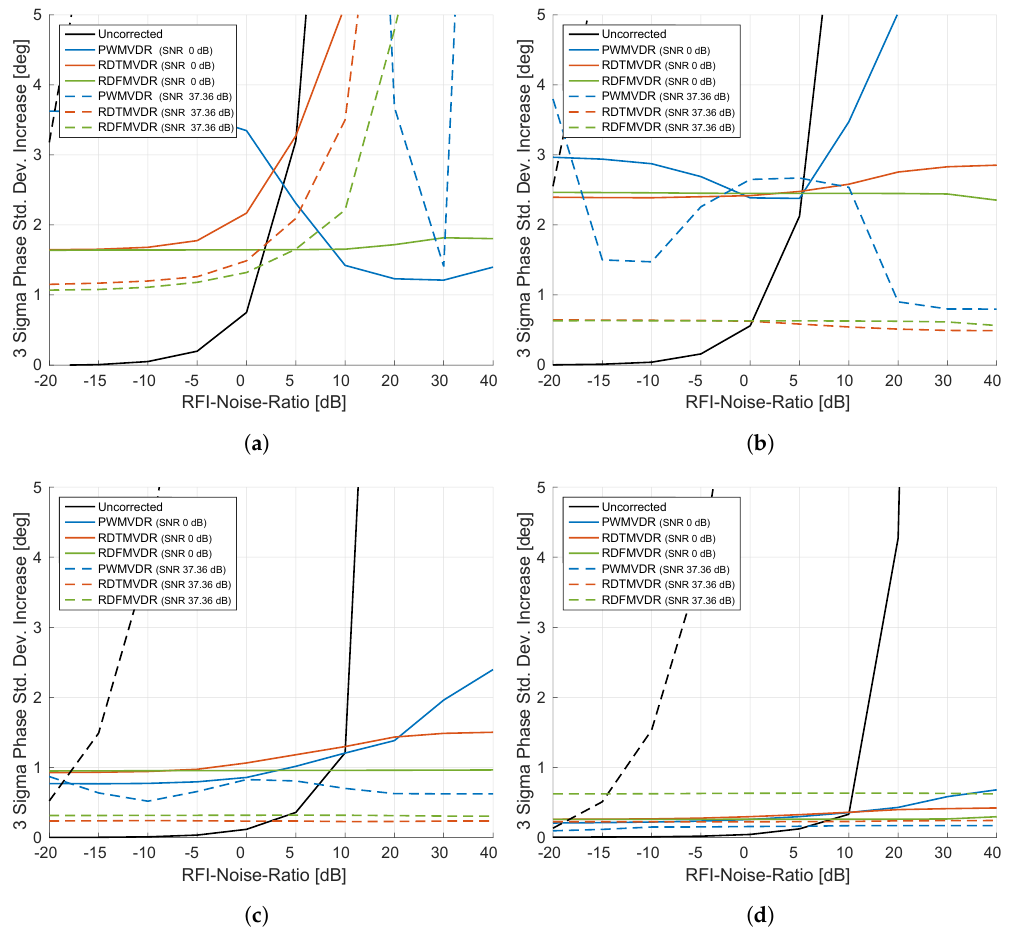
Figure 24. The 3 sigma phase standard deviation error of the residual error image of Scenario A versus RFI-Noise-Ratio. The plots are shown for SNR = 0 dB (solid lines) and SNR = 37.36 dB (dashed lines). ( a ) N = 2, ( b ) N = 4, ( c ) N = 8, ( d ) N =